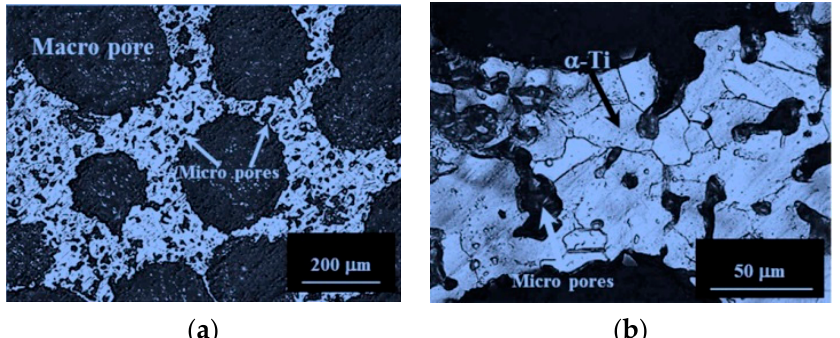
Figure 2. Polished cross-sectional light microscope images of Ti foam with 55.9% porosity showing ( a ) macropores formed by Mg evaporation and microporous cell walls and ( b ) cell walls containing micropores and grains of the α -Ti phase.